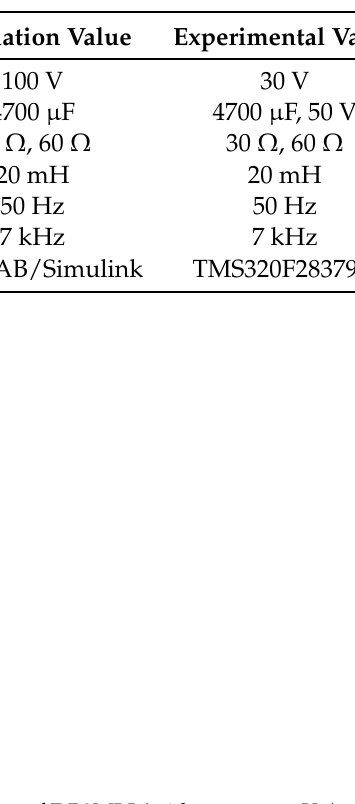
Figure 1. ( a ) Circuit schematic and ( b ) Experimental Setup of of DB9LI. Table 1. Simulation and experimental parameters of DB9LI.